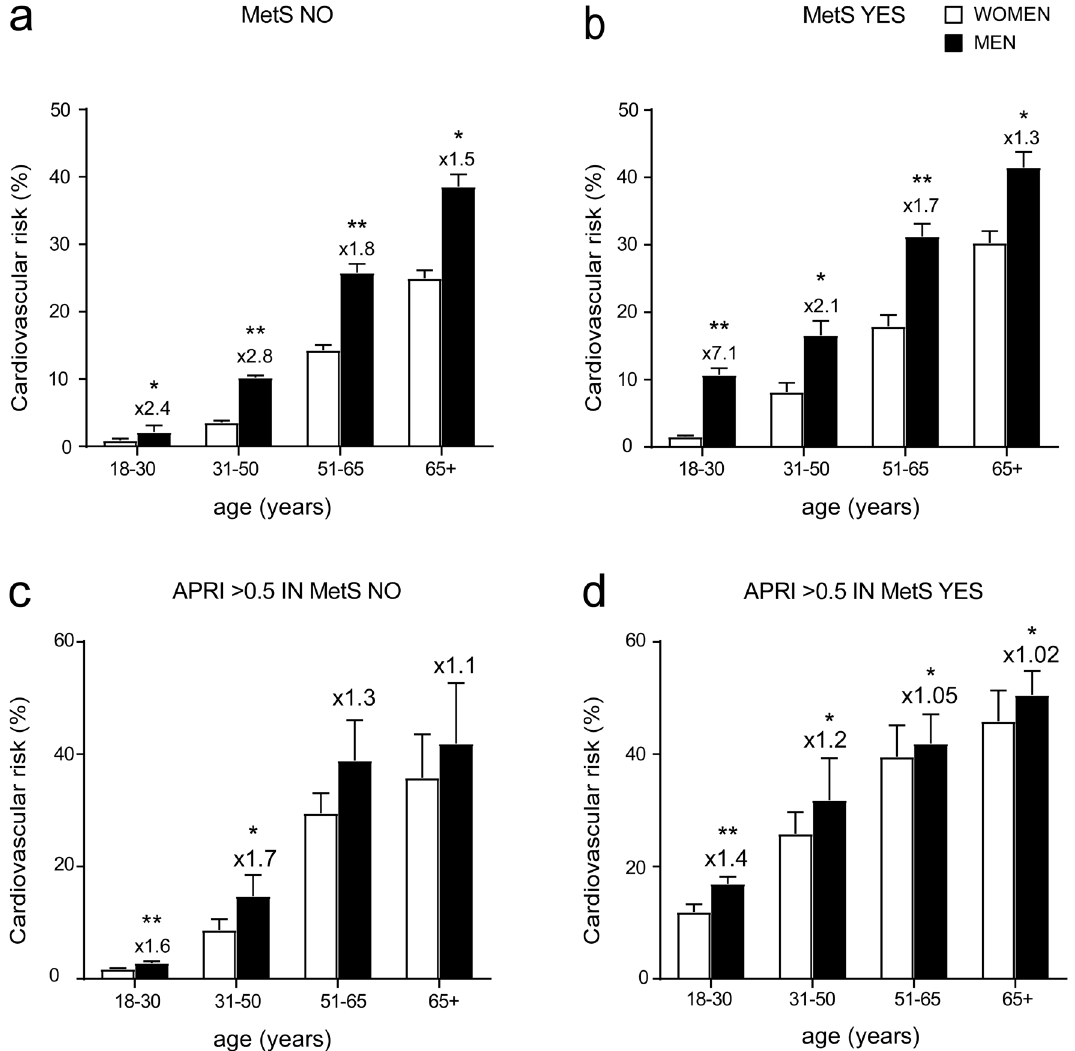
Figure 6. Cardiovascular risk analysis by gender and age. ( a – d ) T-Test comparison of CVR in non-metabolic (MetS NO) subjects ( a ), MetS (MetS YES) subjects ( b ), non-metabolic (MetS NO) subjects with APRI > 0.5 ( c ) and MetS (MetS YES) subjects with APRI > 0.5 ( d ). Subjects were divided based on gender and age. Data is presented as mean ± SEM. Statistical significance was assessed by Student T-test (*p < 0.05, **p < 0.01).. Multipliers are shown to identify difference in CVR in males compared to